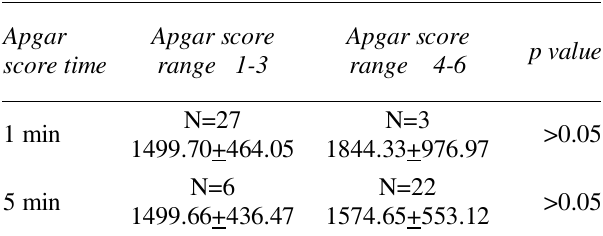
Table 4: Total antioxidant level (µmol/L) in relation to (HIE) & Apgar